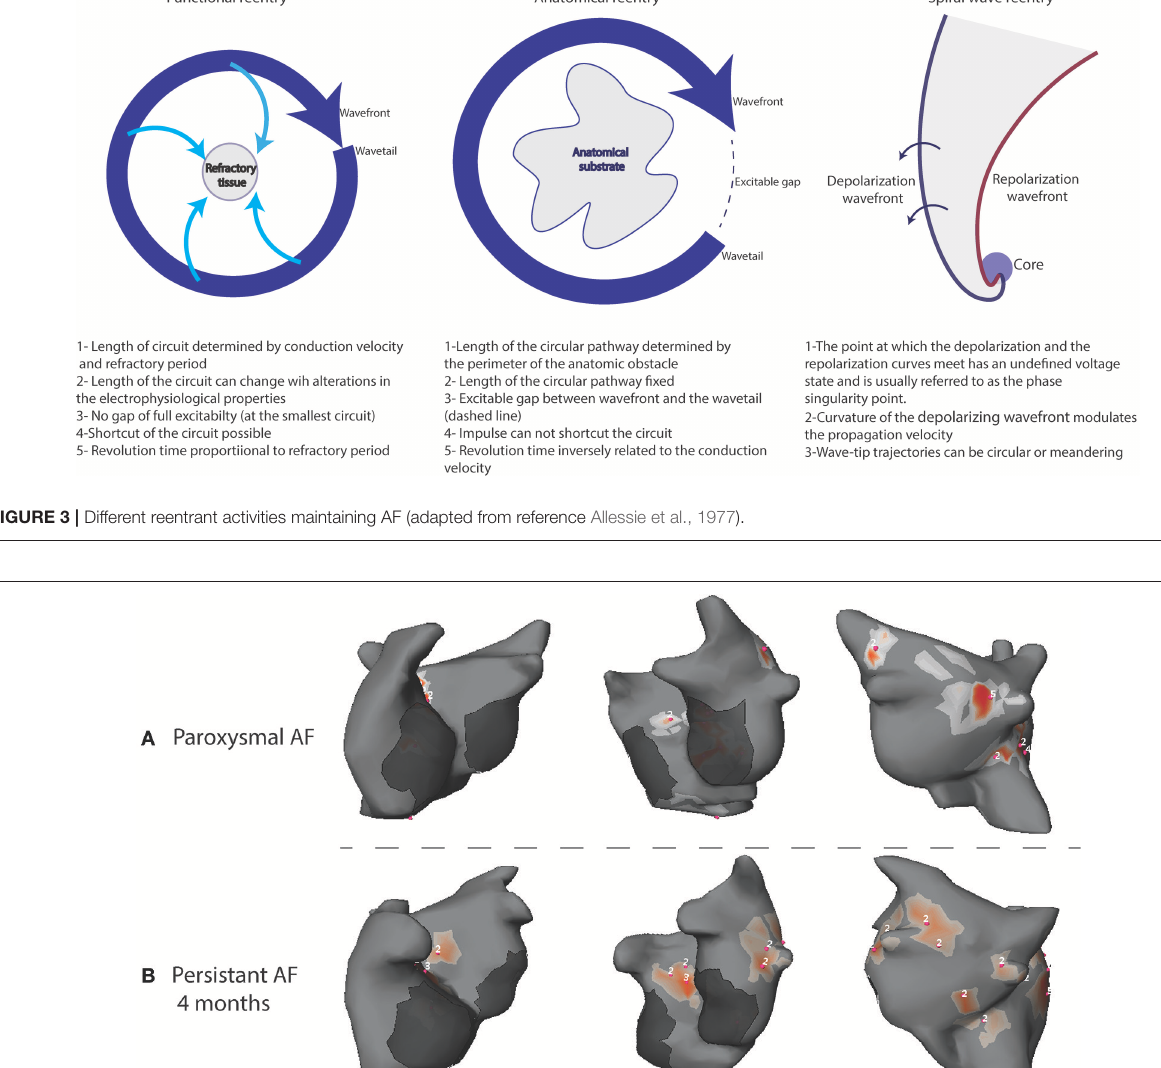
Electrical remodeling AF and rapid arrhythmias alter the expression and/or the function of ion channels in a way that promotes arrhythmias (Allessie et al., 2002; Schotten et al., 2011; Wakili et al.,